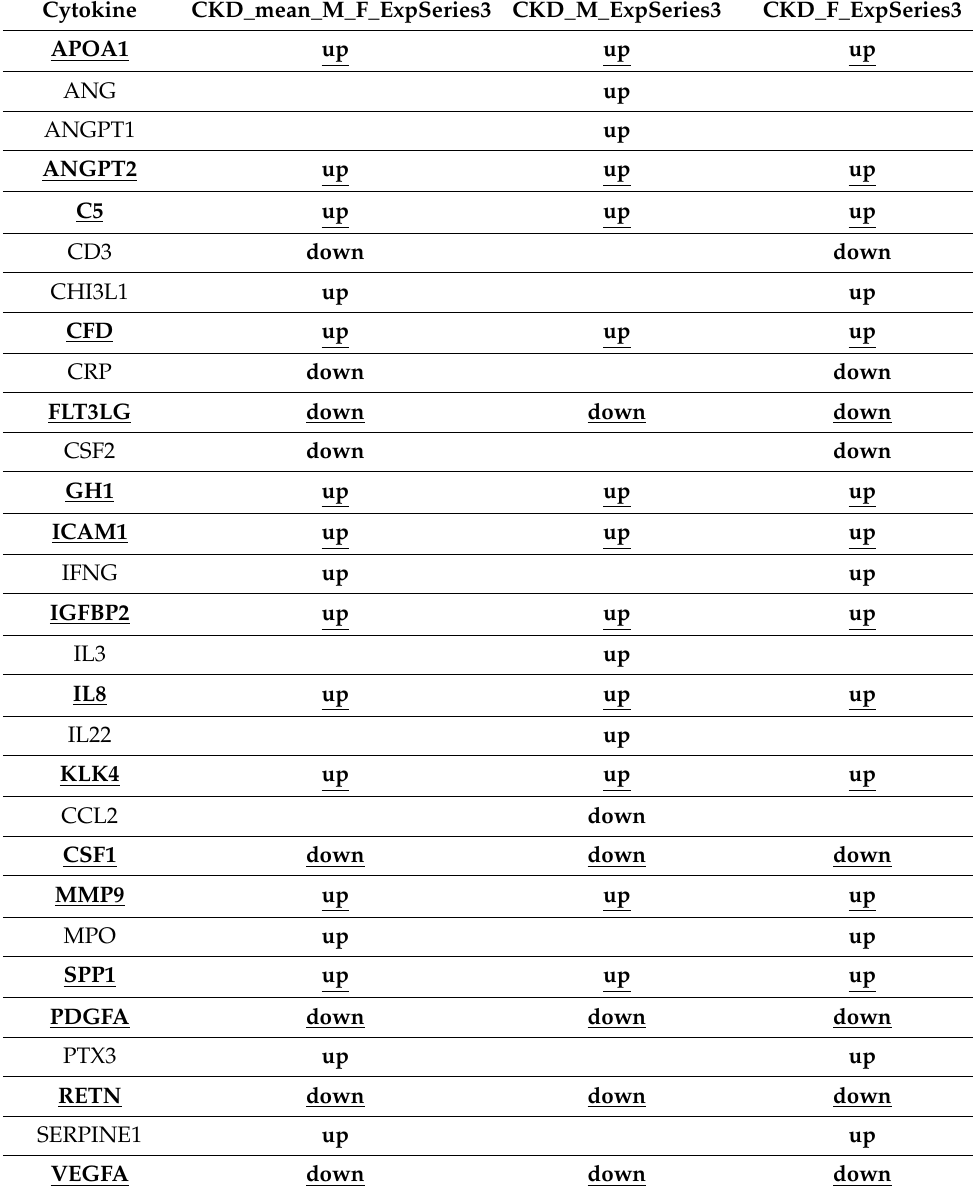
Table 4. CKD-associated cytokine biomarkers identified as common and specific between males and females, based on experiment series